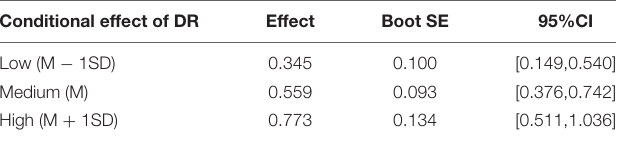
TABLE 6 | Conditional indirect effect at specific levels of psychological resilience when mediated by post-traumatic growth. Conditional effect of